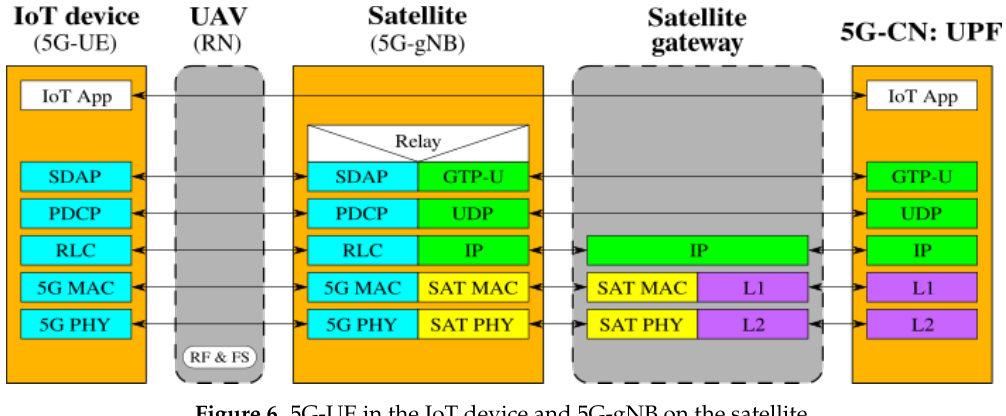
Figure 5. 5G-UE in the IoT device, UAV and satellite as RNs, and terrestrial 5G-gNB.